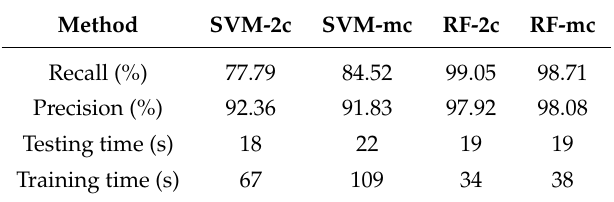
Table 3. Theclassificationresultofdifferentapproaches: Testingtimeistheclassificationtimepermegapixel, including the calculation of reflectance gradients; for definitions of abbreviations, see Section